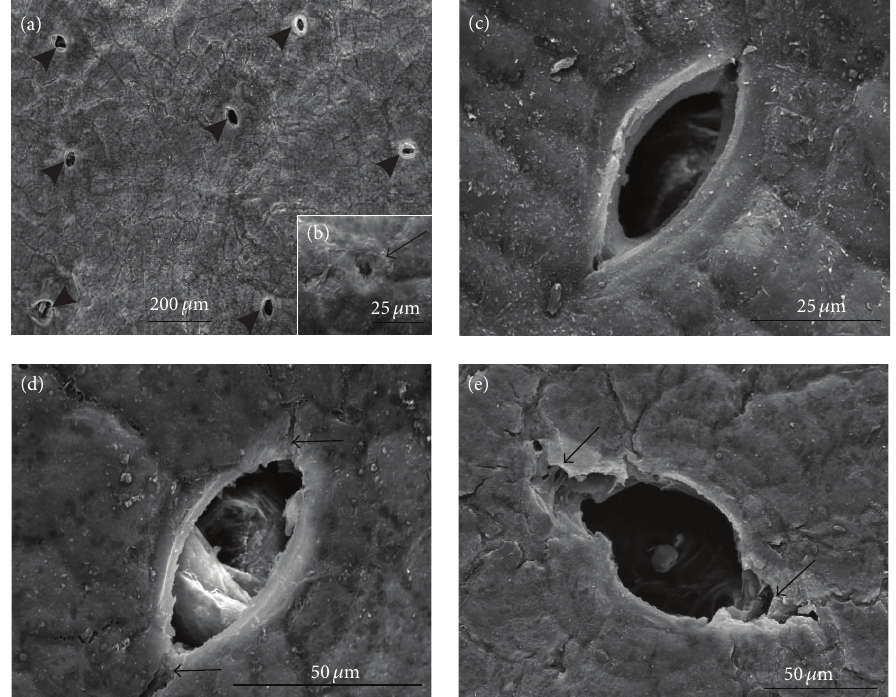
Figure 2: SEM: stomata in the fruit epidermis of the “Clapp’s Favourite” ((a), (b), (d)) and “Conference” ((c), (e)) fruits at the fruit set stage. (a) numerous visible stomata (arrowheads); (b) the site (scar) of a broken off mechanical trichome (arrow) is visible; ((c), (e)) open stomata; (d) stoma with structures of unknown origin; ((d), (e)) stoma with epidermis cracks (arrowheads). to redistilled water and stained with a 0.5 M aqueous solution of uranyl acetate and lead citrate [15]. Images were